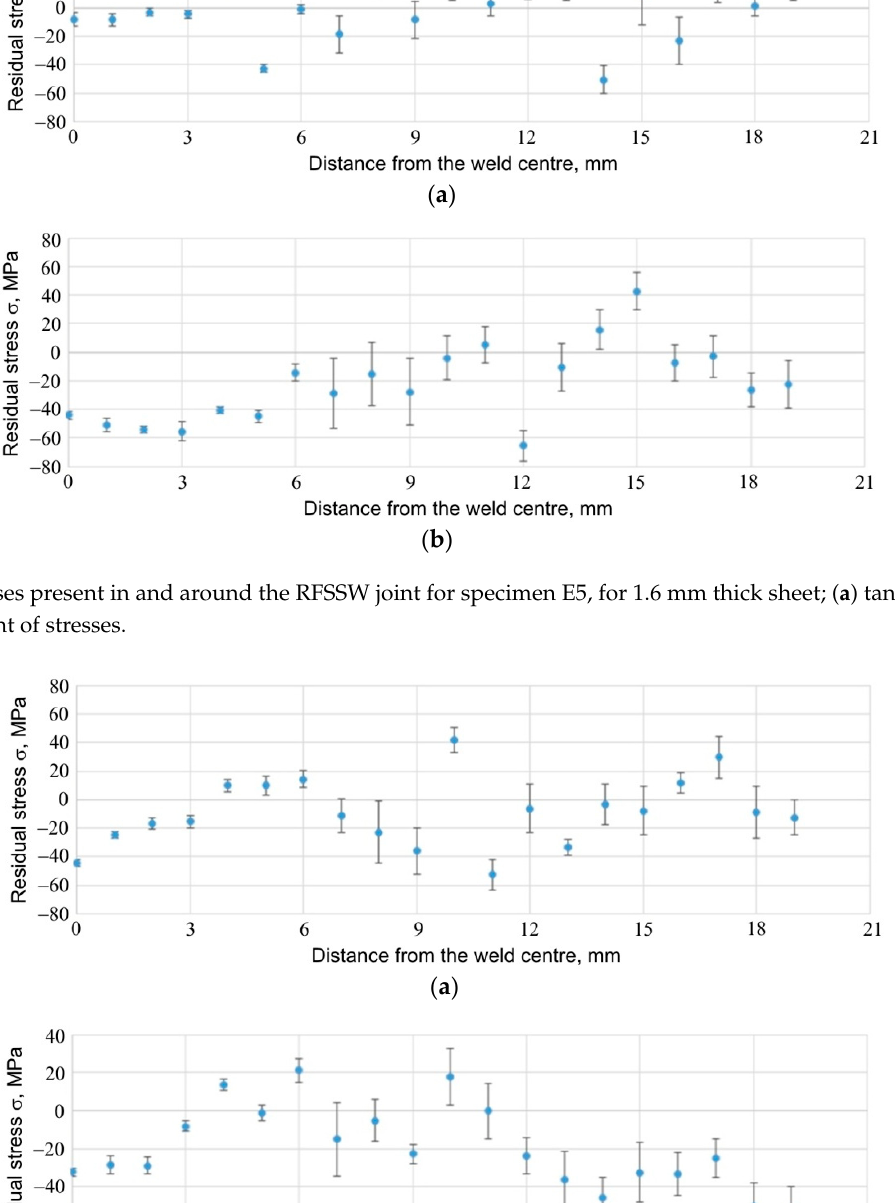
Figure 26. Stresses present in and around the RFSSW joint for specimen E6, for 1.6 mm thick sheet; ( a ) tangential and ( b ) radial component of stresses.